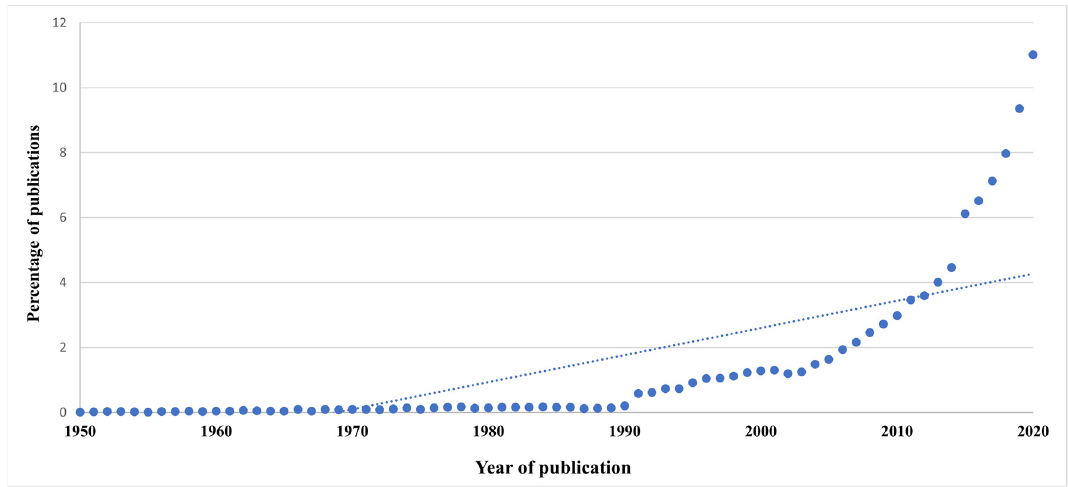
Figure 1. Trends of publications in patient education research.